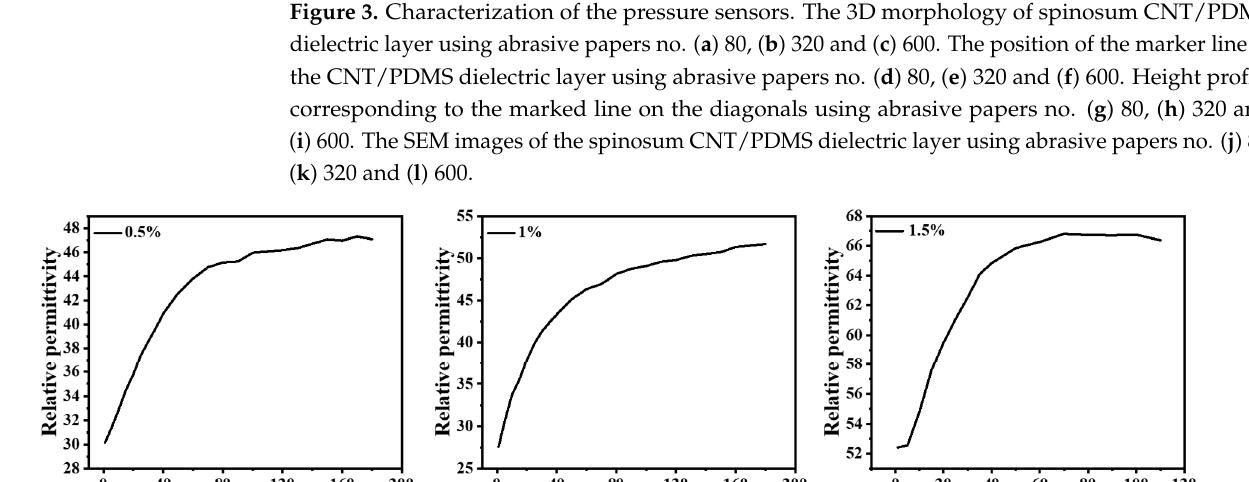
Figure 3. Characterization of the pressure sensors. The 3D morphology of spinosum CNT/PDMS dielectric layer using abrasive papers no. ( a ) 80, ( b ) 320 and ( c ) 600. The position of the marker line of the CNT/PDMS dielectric layer using abrasive papers no. ( d ) 80, ( e ) 320 and ( f ) 600. Height profile corresponding to the marked line on the diagonals using abrasive papers no. ( g ) 80, ( h ) 320 and ( i ) 600. The SEM images of the spinosum CNT/PDMS dielectric layer using abrasive papers no. ( j ) 80, ( k ) 320 and ( l ) 600.